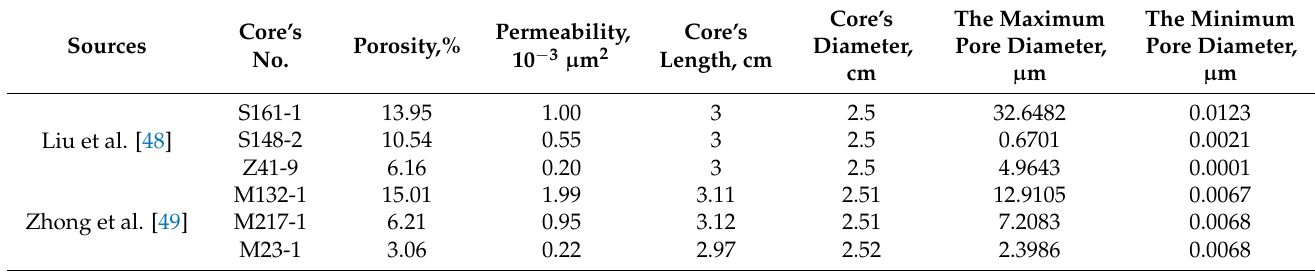
Table 1. The core’s parameters in the works of Liu et al. [48] and Zhong et al.